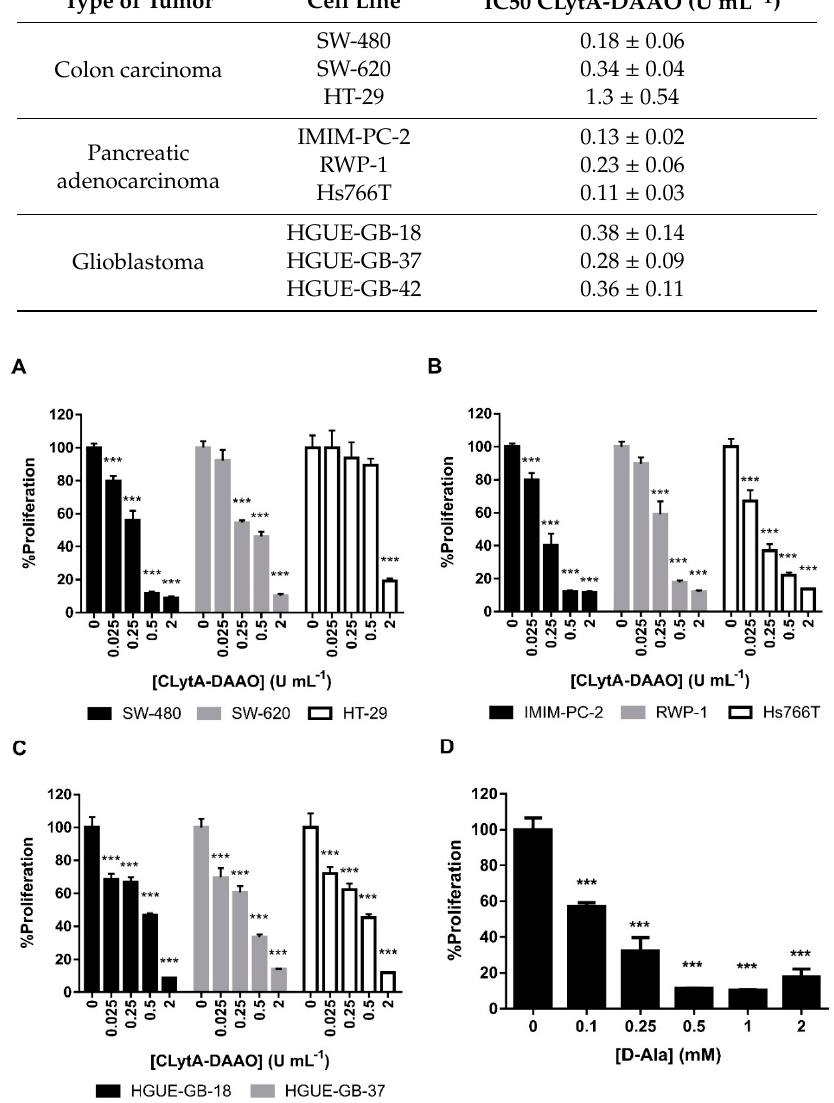
Table 1. IC50 values (U mL − 1 ) of free CLytA-D-amino acid oxidase (DAAO) with 1 mM D-Ala in di ff erent cell lines from colon carcinoma, pancreatic adenocarcinoma, and glioblastoma treated for 72 h. Type of Tumor